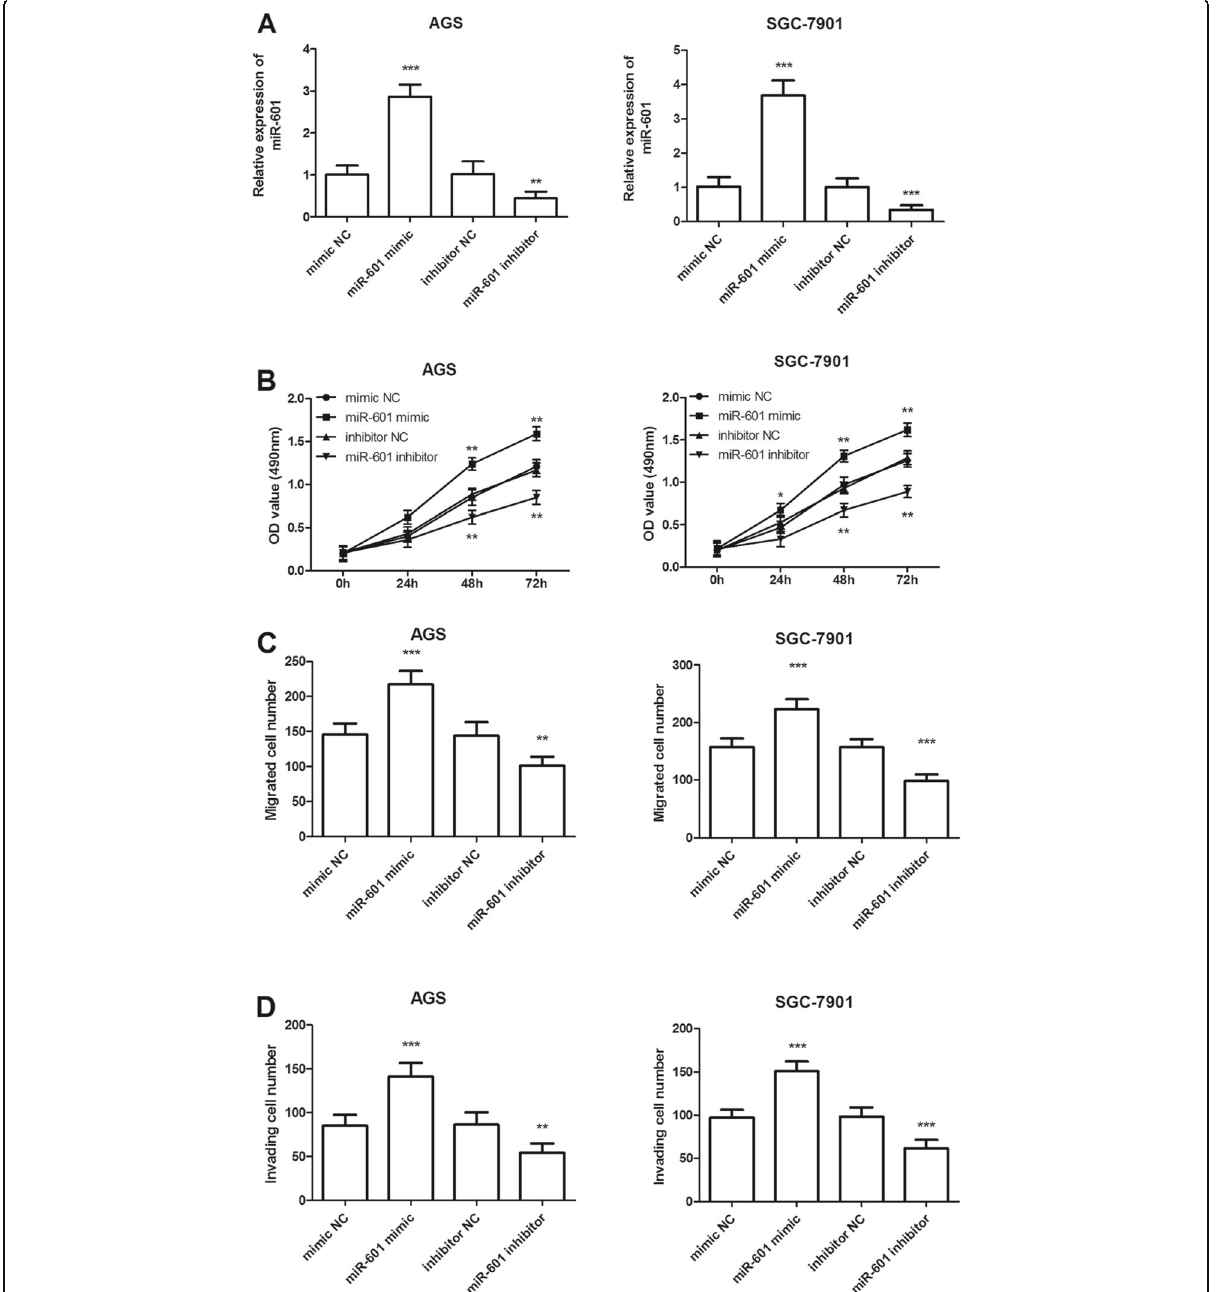
Fig. 3 Effects of miR-601 on cell proliferation, migration and invasion in AGS and SGC-7901 cells. a In the two cell lines, expression of miR-601 was significantly increased by miR-601 mimic transfection, while transfection with miR-601 inhibitors resulted in lower expression than the corresponding negative control (** P < 0.01 and *** P < 0.001). b Cell proliferation was enhanced by overexpression of miR-601, but was suppressed by knockdown of miR-601 in both AGS and SGC-7901 cells (* P < 0.05 and ** P < 0.01). c and d Overexpression of miR-601 by miR-601 mimic transfection could promote the cell migration and invasion, but the downregulated miR-601 expression could inhibit the cell migration and invasion (** P < 0.01 and *** P <